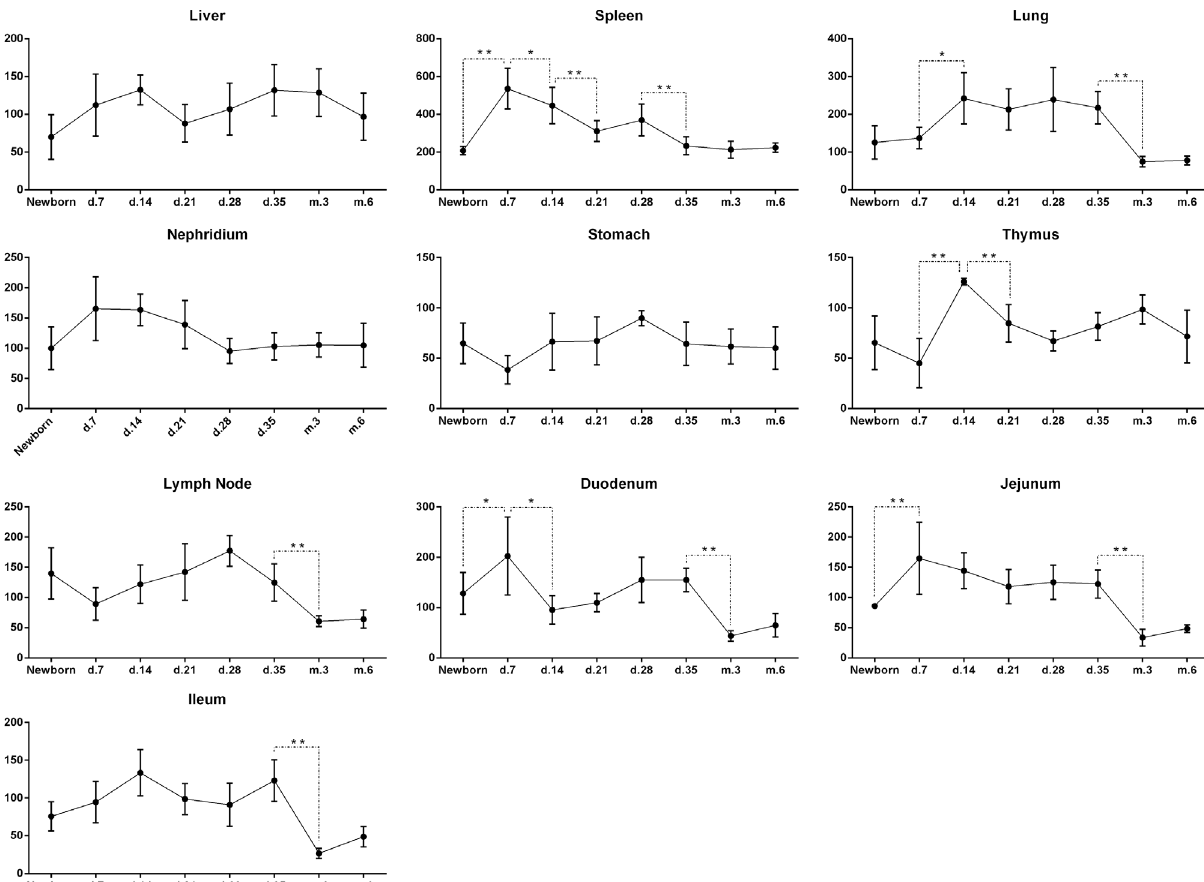
Figure 2 - MYD88 expression levels in each tissue of pigs at days (d.) 7, 14, 21, 28 and 35, and at months (m.) 3 and 5 * P < 0.05; ** P <